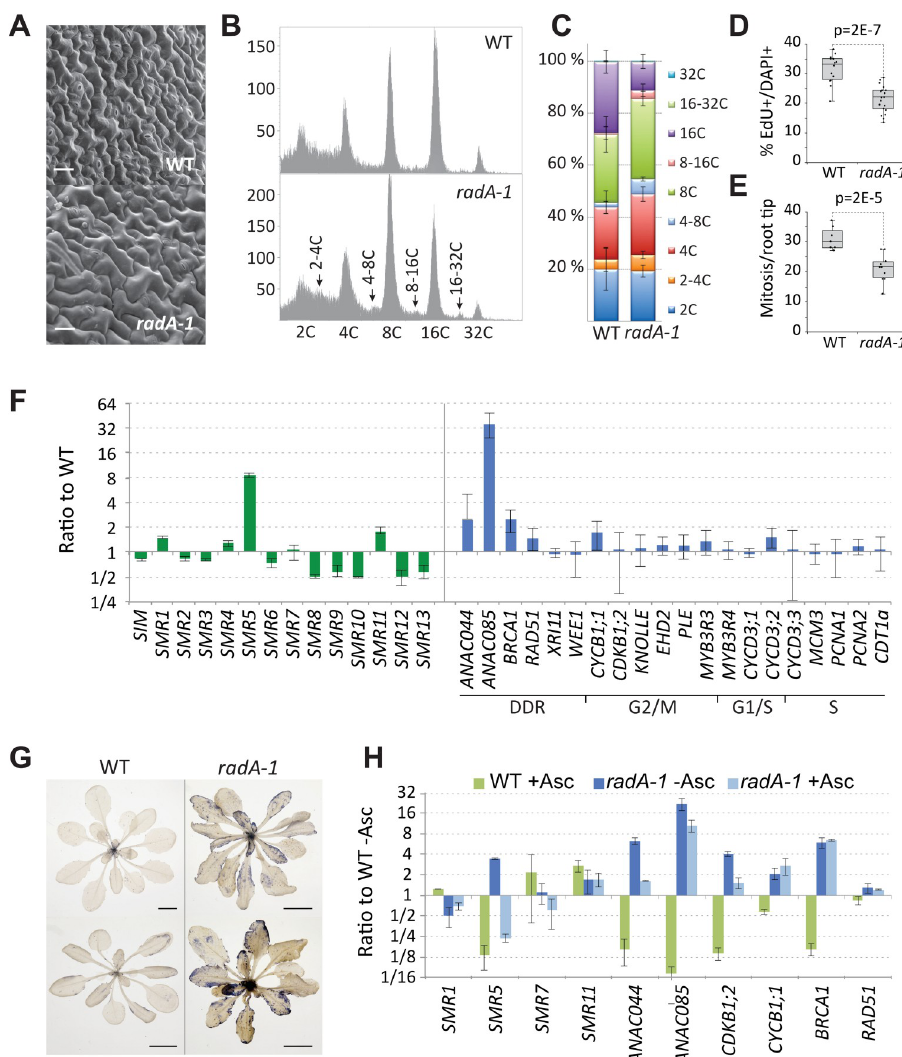
Fig 9. Cell cycle progression is impaired in radA plants. (A) Scanning electron microscopy images showing much larger epidermal cells and fewer stomata in radA leaves. Scale bar is 20 μ m. (B) Flow-cytometry profiles of WT and radA . The DNA content of nuclei extracted from the first true leaves of 20-day-old plants was analyzed. (C) Ploidy distribution, showing decreased endoreduplication in the mutant, with an increased proportion of 4C and 8C nuclei and a decreased proportion of 16C nuclei. Values are the mean ± SD from 4 experiments for WT and from six experiments for radA (n > 20 000 nuclei). (D) Decreased DNA synthesis in the nuclei of radA root tip cells, as evaluated by the ratio between EdU positive and DAPI positive cells. (E) Decreased number of cells undergoing mitosis. Significances were calculated by Student’s t test. (F) RT-qPCR analysis of the expression of a set of cell cycle related genes in 10-day-old WT and radA seedlings, revealing significant activation of SMR5 and ANAC085 . The data is represented in a log2 scale and is the mean ± SD of three biological replicates. (G) NBT (nitro blue tetrazolium) staining for O 2- , in plants of equivalent size grown under the same conditions, showing accumulation of ROS in radA plants. Scale bar is 1 cm. (H) The expression of several cell cycle-related genes is suppressed by the ROS quencher ascorbic acid (1 mM), both in WT and in radA 10-day-old